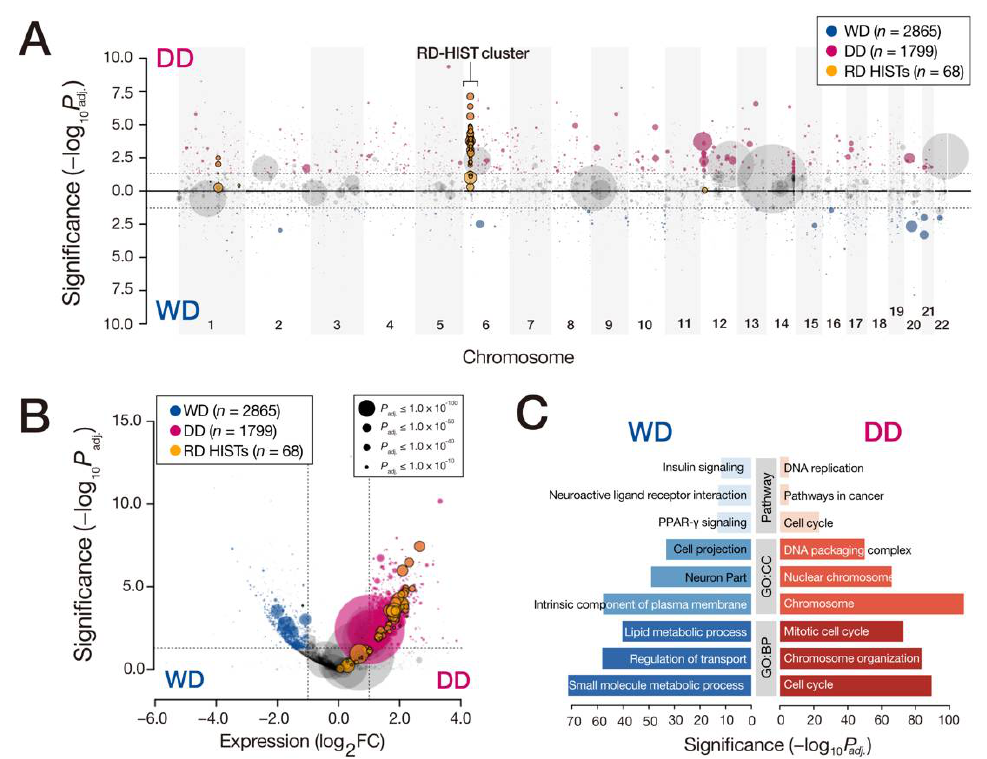
Figure 1. RD-HIST overexpression delineated the difference between WD- and DDLPS. ( A ) Genome- wide view of the differentially expressed genes between 11 WD- and 13 DDLPS tumors, plotted as significances of the differential expression between the two groups. Genes that displayed higher expression in DDLPS are shown in the upper part, whereas higher expressions in WDLPS are in the lower part. Circle sizes denote fold changes in the expression of WD- and DDLPS tumors from the normal adipocyte tissues. ( B ) Volcano plot of the transcripts shown in ( A ), displaying differentially expressed genes in red (up in DDLPS), blue (up in WDLPS), and yellow (RD-HIST genes). ( C ) Gene ontology classes selected from DEGs; p -values were from the Wilcoxon rank-sum test, adjusted using the Bonferroni correction method.